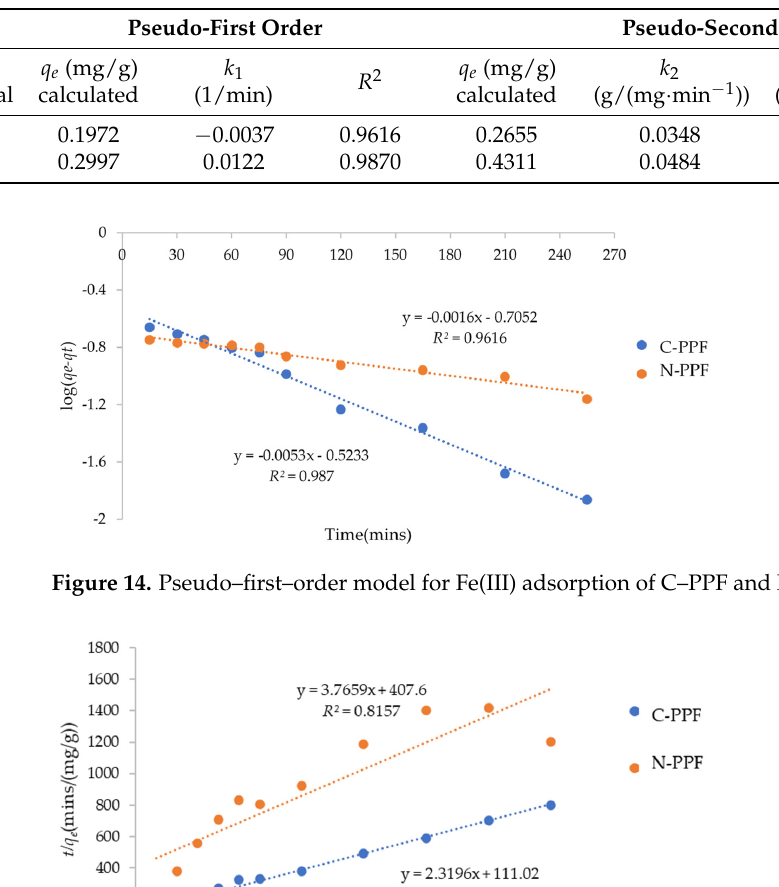
Table 4. Kinetic parameters of Fe(III) adsorption on C–PPF and N–PPF at 303 K.